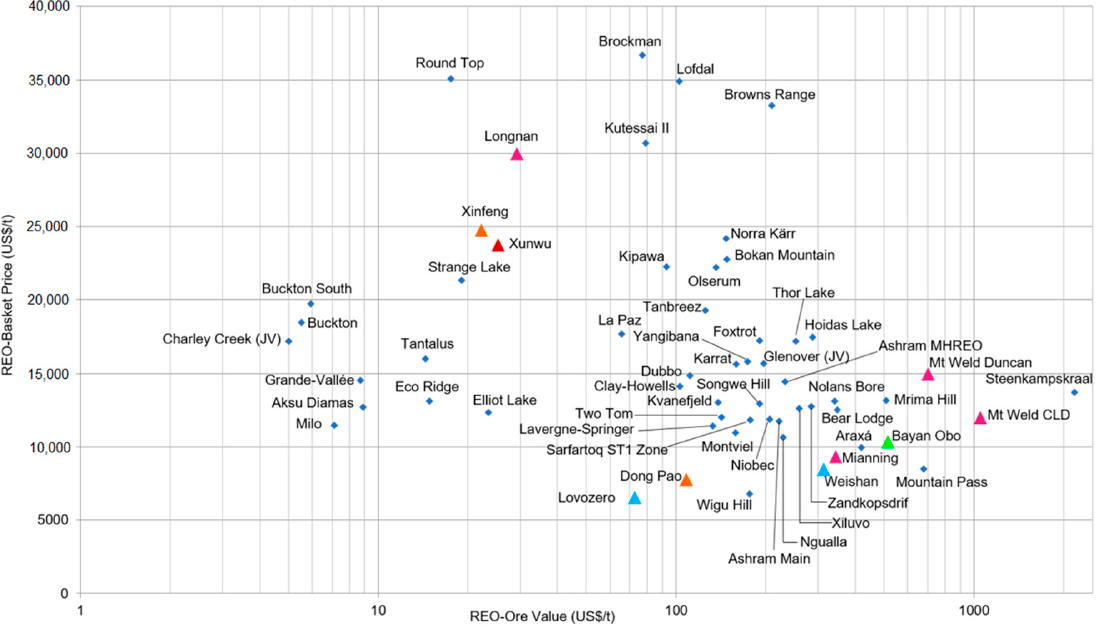
Figure 8. The ore value and basket price for advanced stage REE deposits.